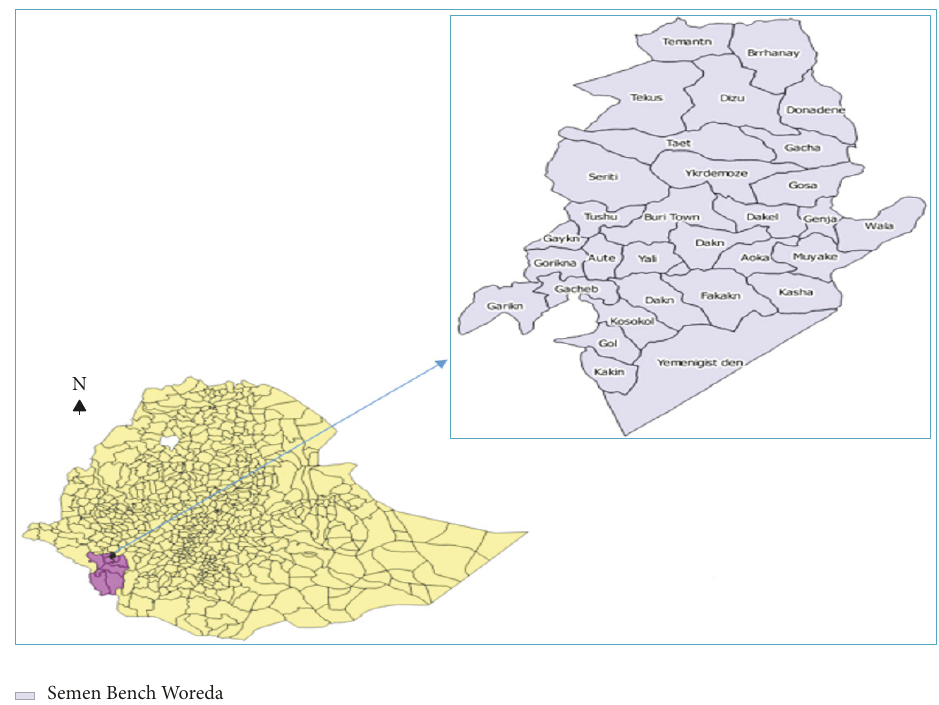
Figure 1: Map of Semen Bench